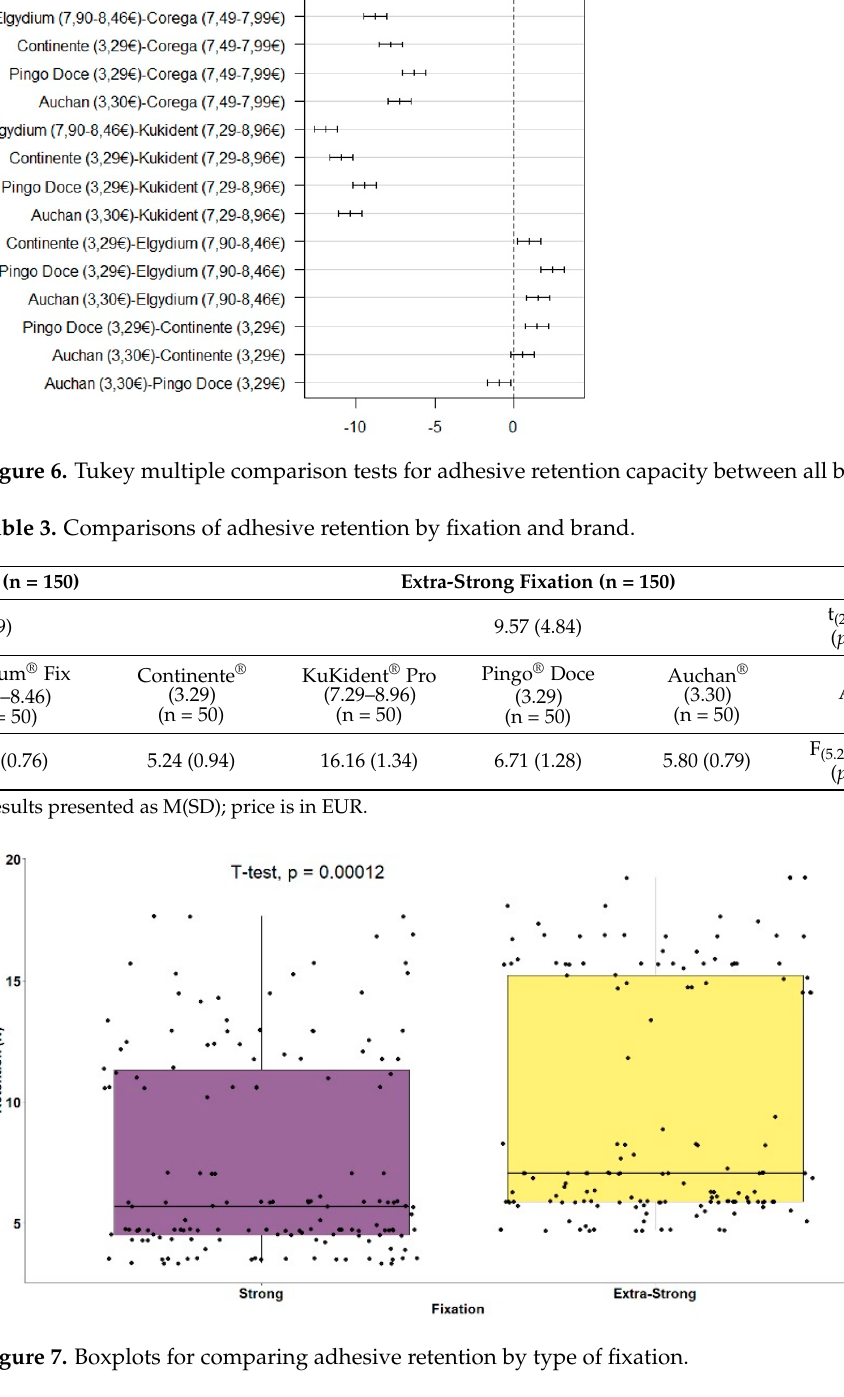
Figure 6. Tukey multiple comparison tests for adhesive retention capacity between all brands.